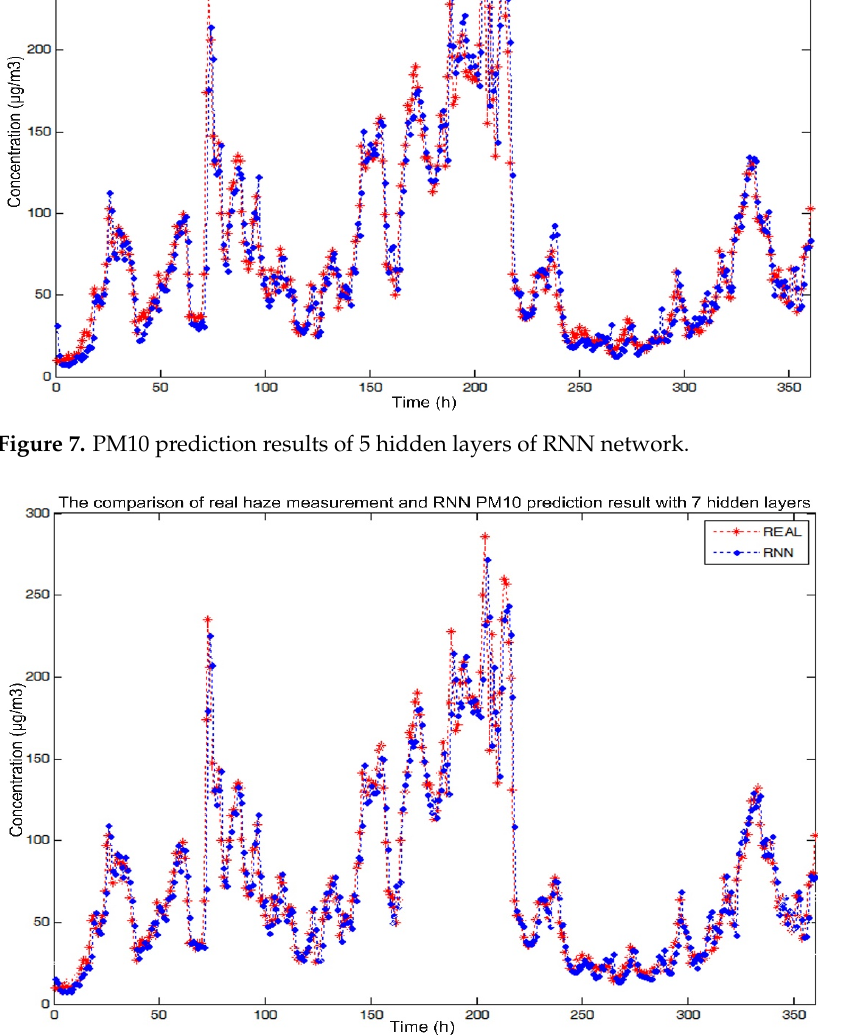
Figure 8. PM10 prediction results of 7 hidden layers of RNN network.